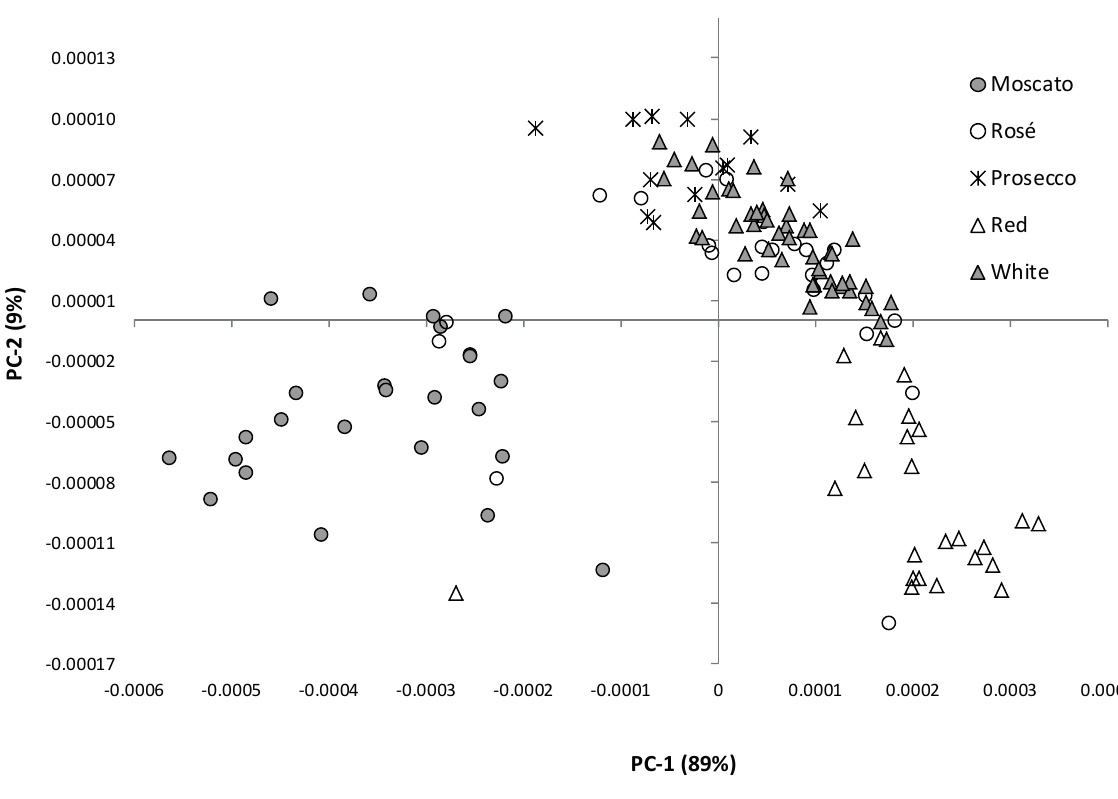
Figure 2. Score plot of the first two PC’s derived from the MIR ‘fingerprint’ (1500–900 cm − 1 ) of white, rosé, red, Prosecco and Moscato wines ( n = 50, 25, 25, 14 and 25,